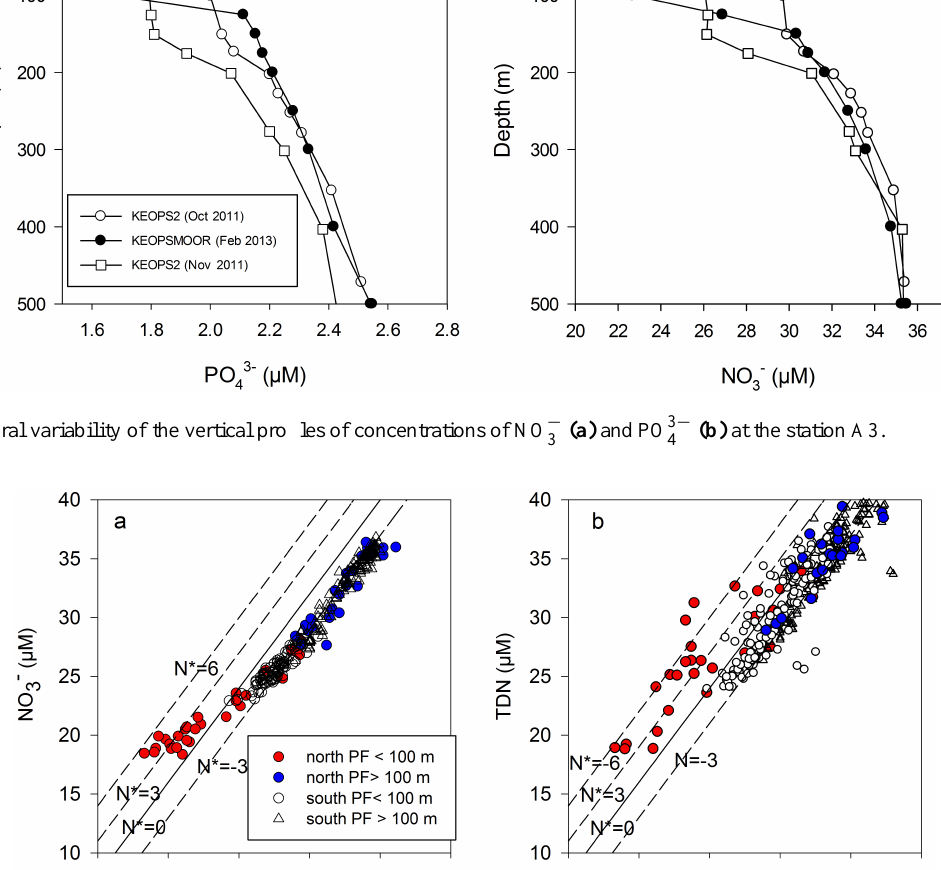
versus PO 3 − . Dots denote the samples, and lines show different values of 3 4